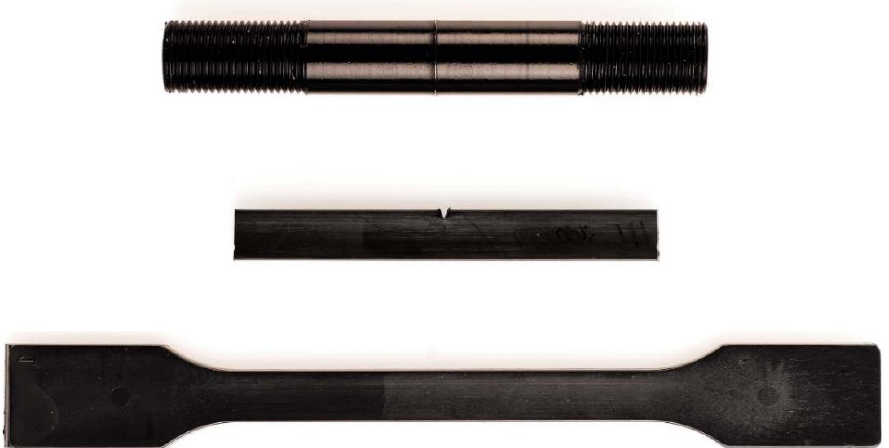
Figure 2. Image of the specimens used in this work made from B75 from top down: CRB specimen lathed from a pressed plate, Type 1 Charpy specimen cut from an MPS, and injection-molded MPS.